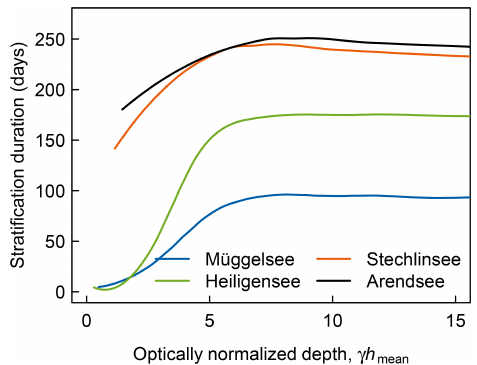
Figure 11. Stratification duration vs. optically normalized depth (mean extinction ( γ , m − 1 ) × mean depth ( h mean , m), dimension- less) in lakes Müggelsee, Heiligensee, Stechlinsee, and Arendsee. The curves are loess-smoothed and are based on ensemble simula- tions with the baseline extinction in each lake for the 2090–2099